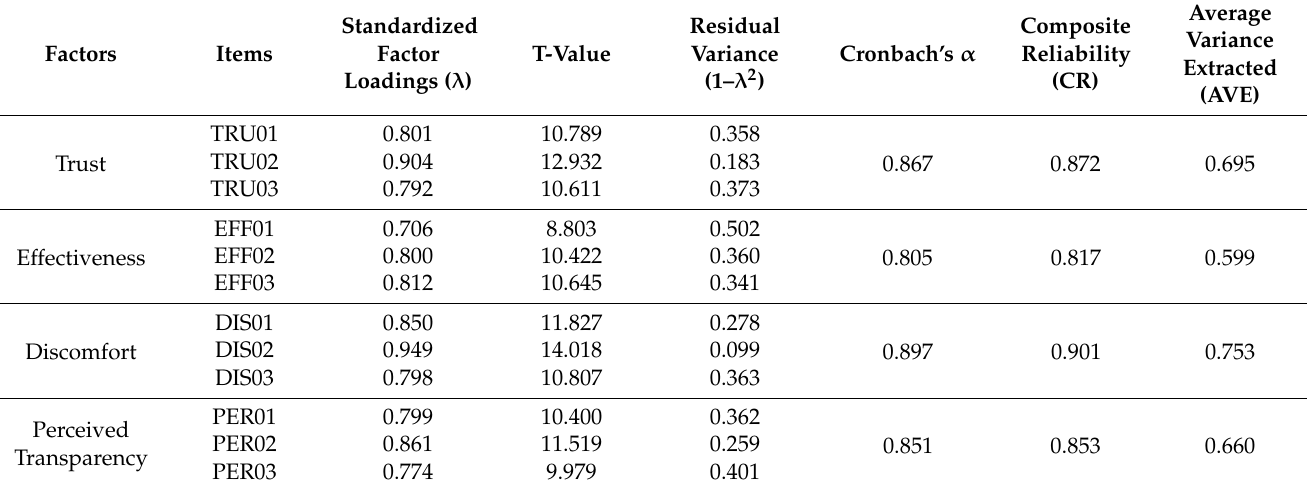
Table 2. Results of reliability and validity analysis.